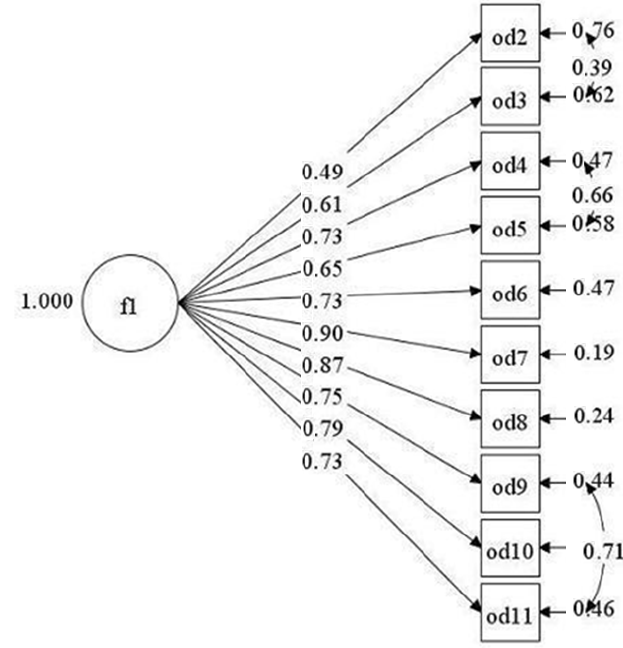
Figure 1. Model of the Organizational Dehumanization Scale.